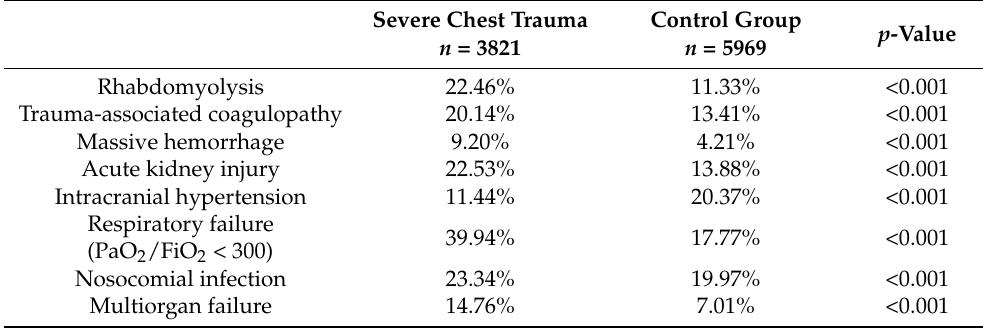
Table 4. Percentage of complications in the severe chest trauma and control